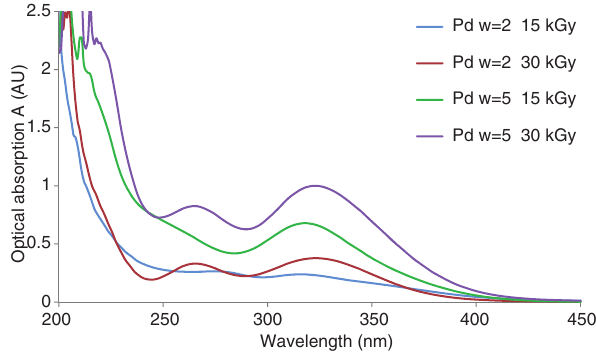
Figure 3 Absorption spectra of Pd RadChem NPs (Dose = 15 kGy and 30 kGy) in reversed micellar solutions at different values: ω